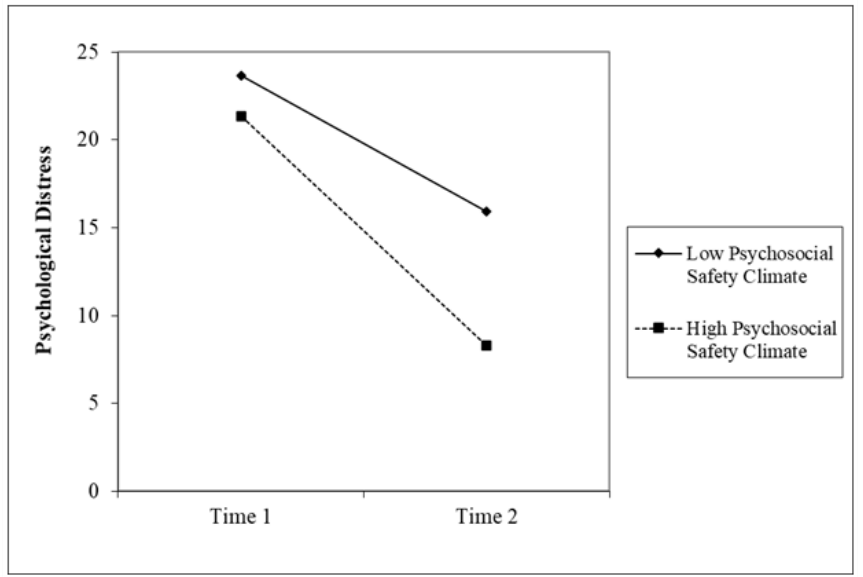
Figure 1 . PSC × Time interaction to predict GHQ.